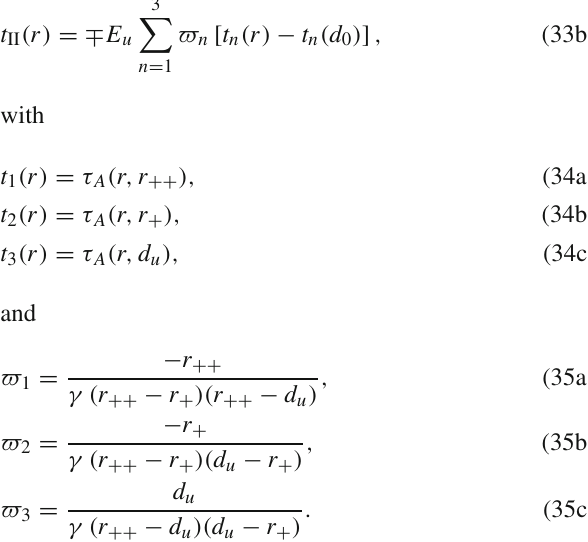
Fig. 4 The plots of FSFK (blue) and FSSK (red), for γ = 0 . 04 and in accordance with three different energies E 2 = 0 . 1 , 0 . 15 and 0 . 21 (from bottom to top), corresponding to three different initial points for each of the cases (i.e. d s for FSFK and d f for FSSK). The thick curves show the radial evolution of the proper time τ( r ) , whereas the thin ones demonstrate that of the coordinate time t ( r )